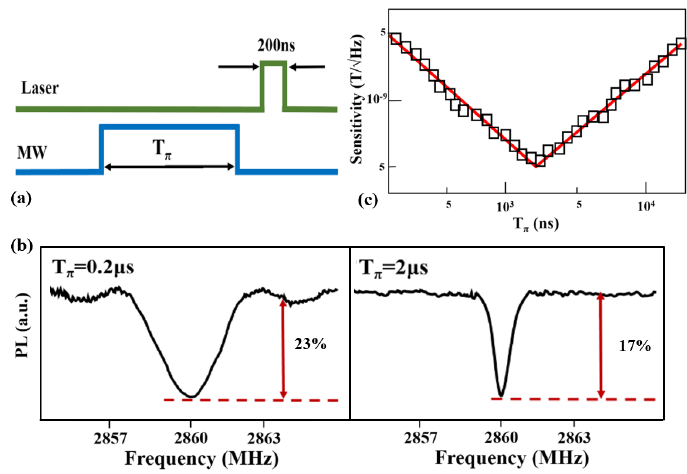
Figure 3. The magnetic field sensitivity using pulse sequence. ( a ) Pulse sequence used to suppress power broadening effects. ( b ) Magnetic resonance spectrum recorded at the excited-state for different duration T π . ( c ) An enhancement of magnetic field sensitivity by one order-of-magnitude.